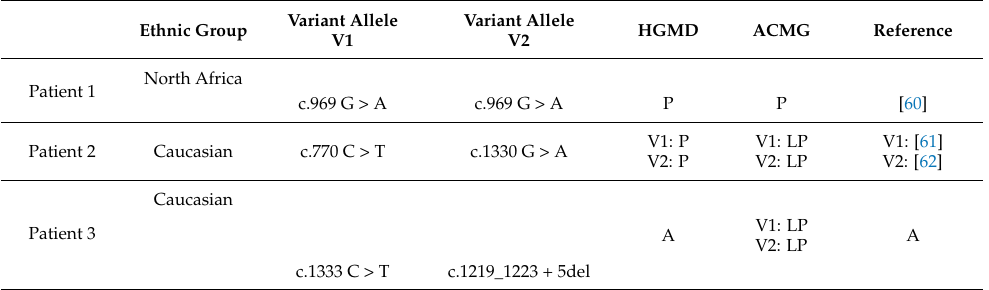
Table 2. Patient ethnic group and genotypes. HGMD: Human Gene Mutation Database. ACMG: American College of Medical Genetics and Genomics. P: Pathogenetic. LP: Likely Pathogenetic. A: Absent. US: Uncertain Significance. LB: Likely Benign. B: Benign.